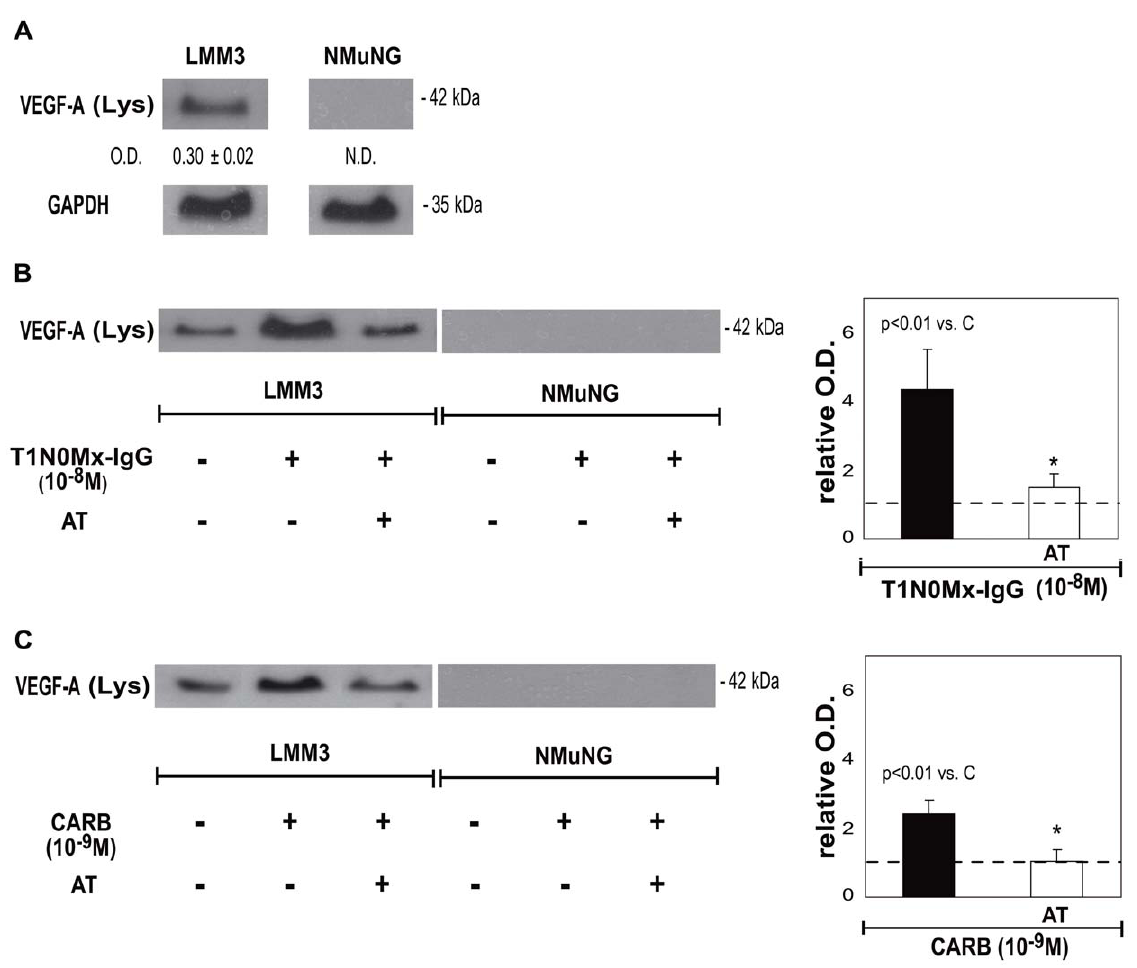
Figure 4. Effect of T1N0Mx-IgG on VEGF-A expression in murine tumor cells. A) LMM3 and NMuMG cell lysates (Lys). Optical density (O.D.) of the bands was calculated by densitometric analysis, and values were relativized to the expression of glyceraldehyde-3-phosphate dehydrogenase (GAPDH). N. D. not detectable. One representative experiment of three is shown. Values are mean 6 S.E.M. Molecular weights are indicated on the right. LMM3 cells were treated with B) T1N0Mx-IgG or C) carbachol (CARB) in the absence or presence of 10 2 8 M atropine (AT). Densitometric analysis of the bands is shown in the right pannel. Values were relativized to the expression of VEGF-A in LMM3 cells without treatment considered as 1, and is represented by a dotted line. Values are mean 6 S.E.M. of three experiments. * p , 0.01 vs. T1N0Mx-IgG or CARB. Molecular weights are indicated on the right.